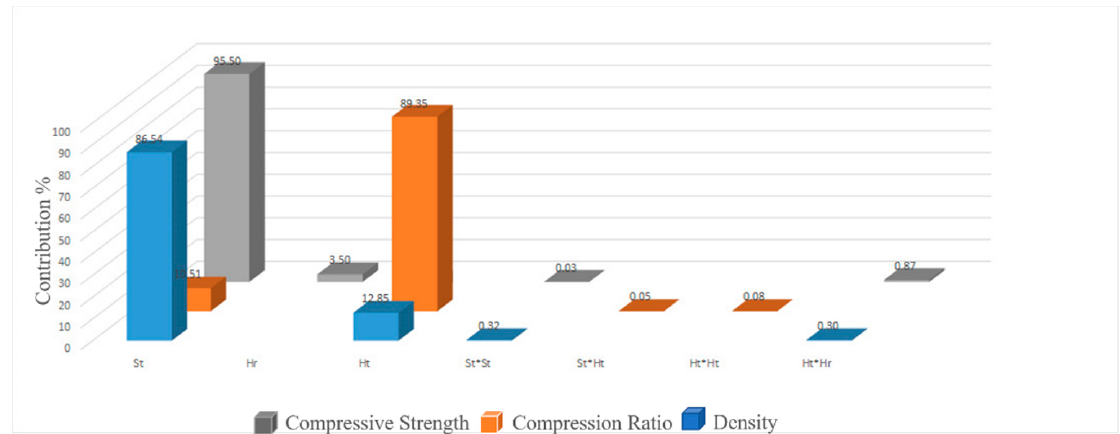
Figure 8. Histogram of the contribution of St, Ht, and Hr to the performance of sintered samples. For compression ratio, the p values of Hr, Hr × Hr, St × St, Hr × Ht and St × Hr were higher than 0.05, indicating that the influence of these parameters should be neglected.